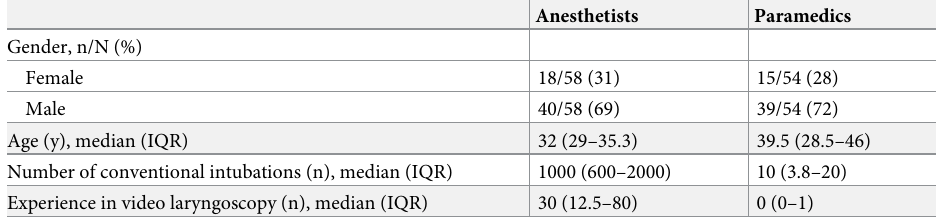
Table 1. Participant characteristics and self-reported estimates of previous experience in conventional and video